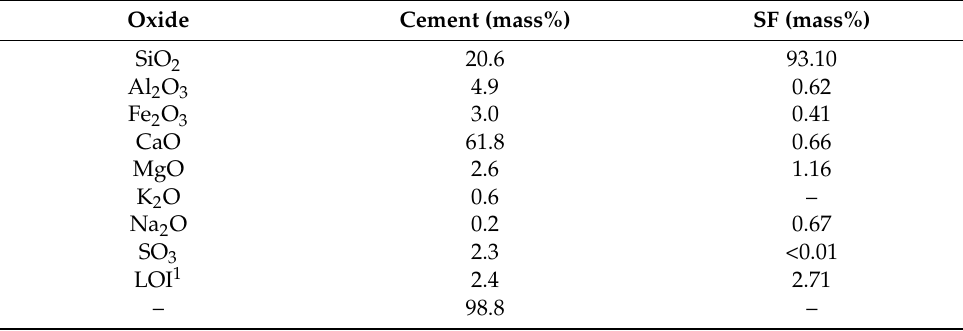
Table 1. Chemical compositions of the binder